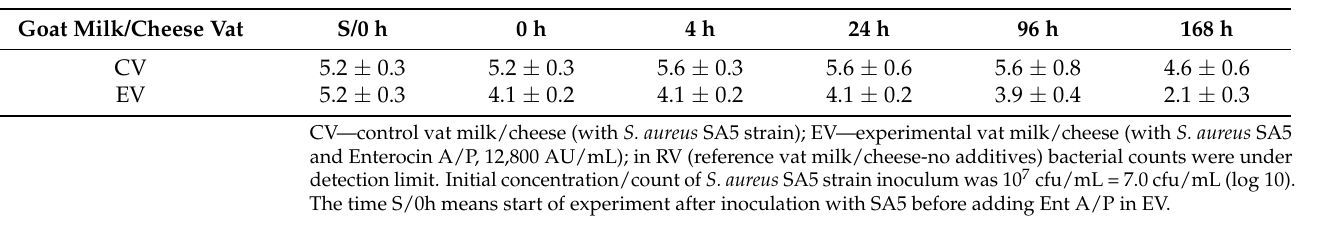
Table 1. The counts of staphylococci during goat cheese manufacturing and storing expressed in colony forming units per mL and/or per gram ±